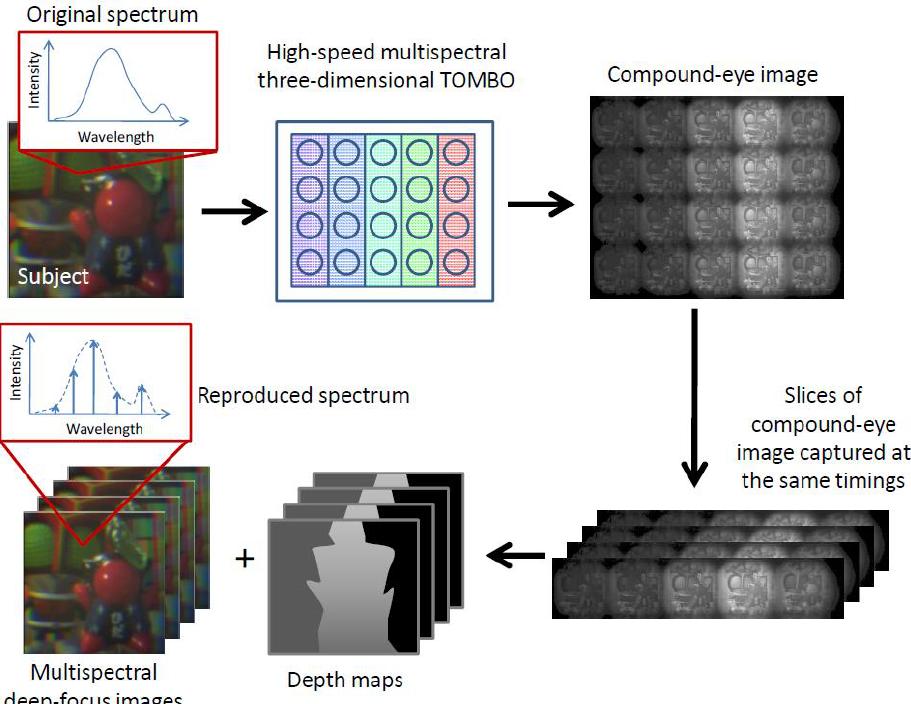
Figure 18. Flowchart of the proposed system.